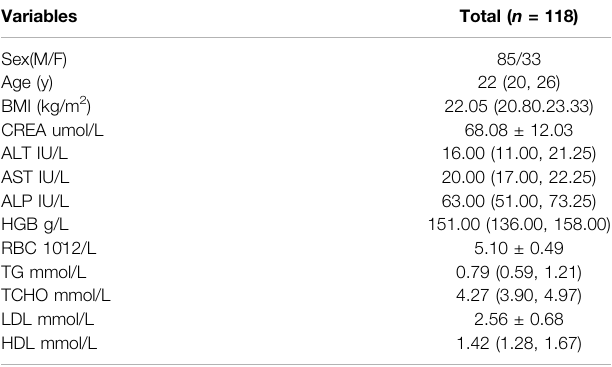
TABLE 1 | Basic characteristics of Chinese healthy volunteers.